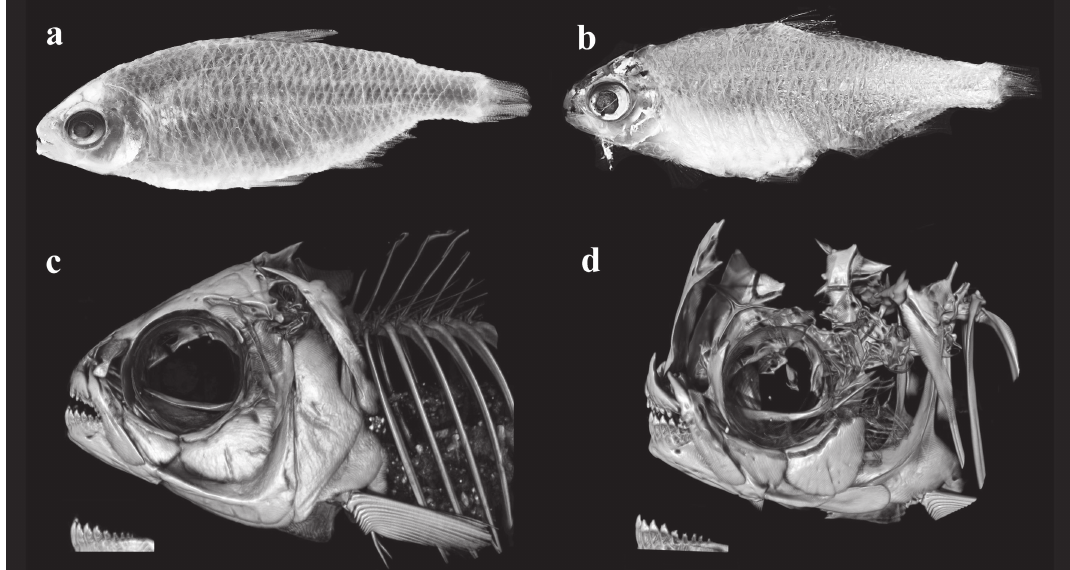
Fig. 3 Two paralectotypes of Deuterodon pedri , MCZ 17510. a-c. Photograph and X-ray computed tomography of the paralectotype with 72.1 mm SL, showing the dentary teeth decreasing gradually in size, corresponding to D. pedri . b-d. Photograph and X-ray computed tomography of the paralectotype with 58.6 mm SL, showing the dentary teeth decreasing abruptly, corresponding to Astyanax intermedius .